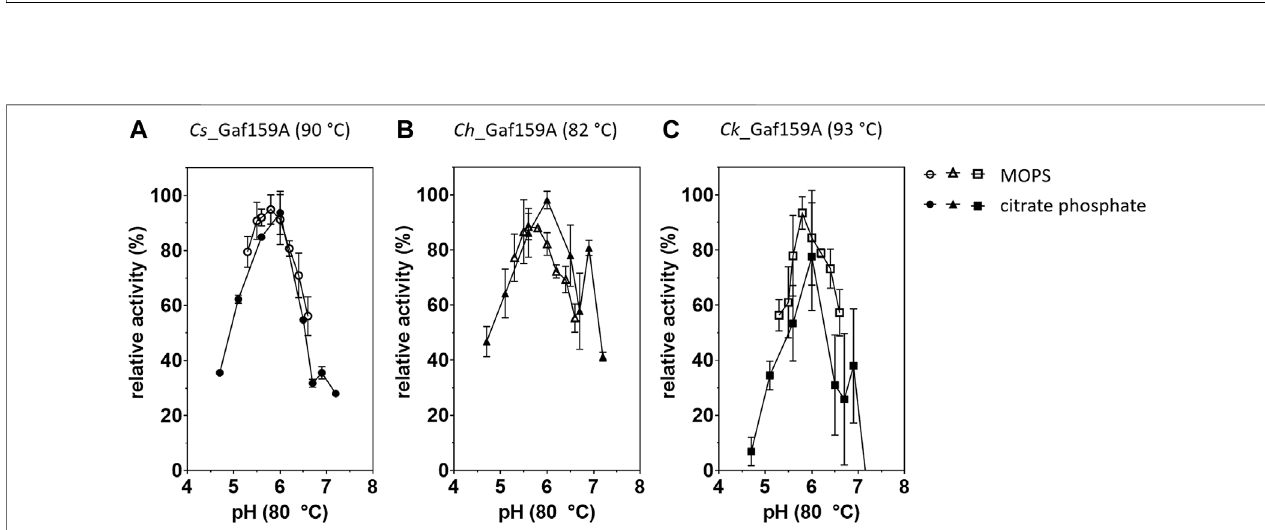
FIGURE 4 | Effect of temperature on pNPAase activity of Cs _Gaf159A (A) , Ch _Gaf159A (B) and Ck _Gaf159A (C) . Relative activities to the maximal activity measured after 20 min were calculated from p NP standard reactions (2.65 µM enzyme). Bars represent standard deviation from triplicates.